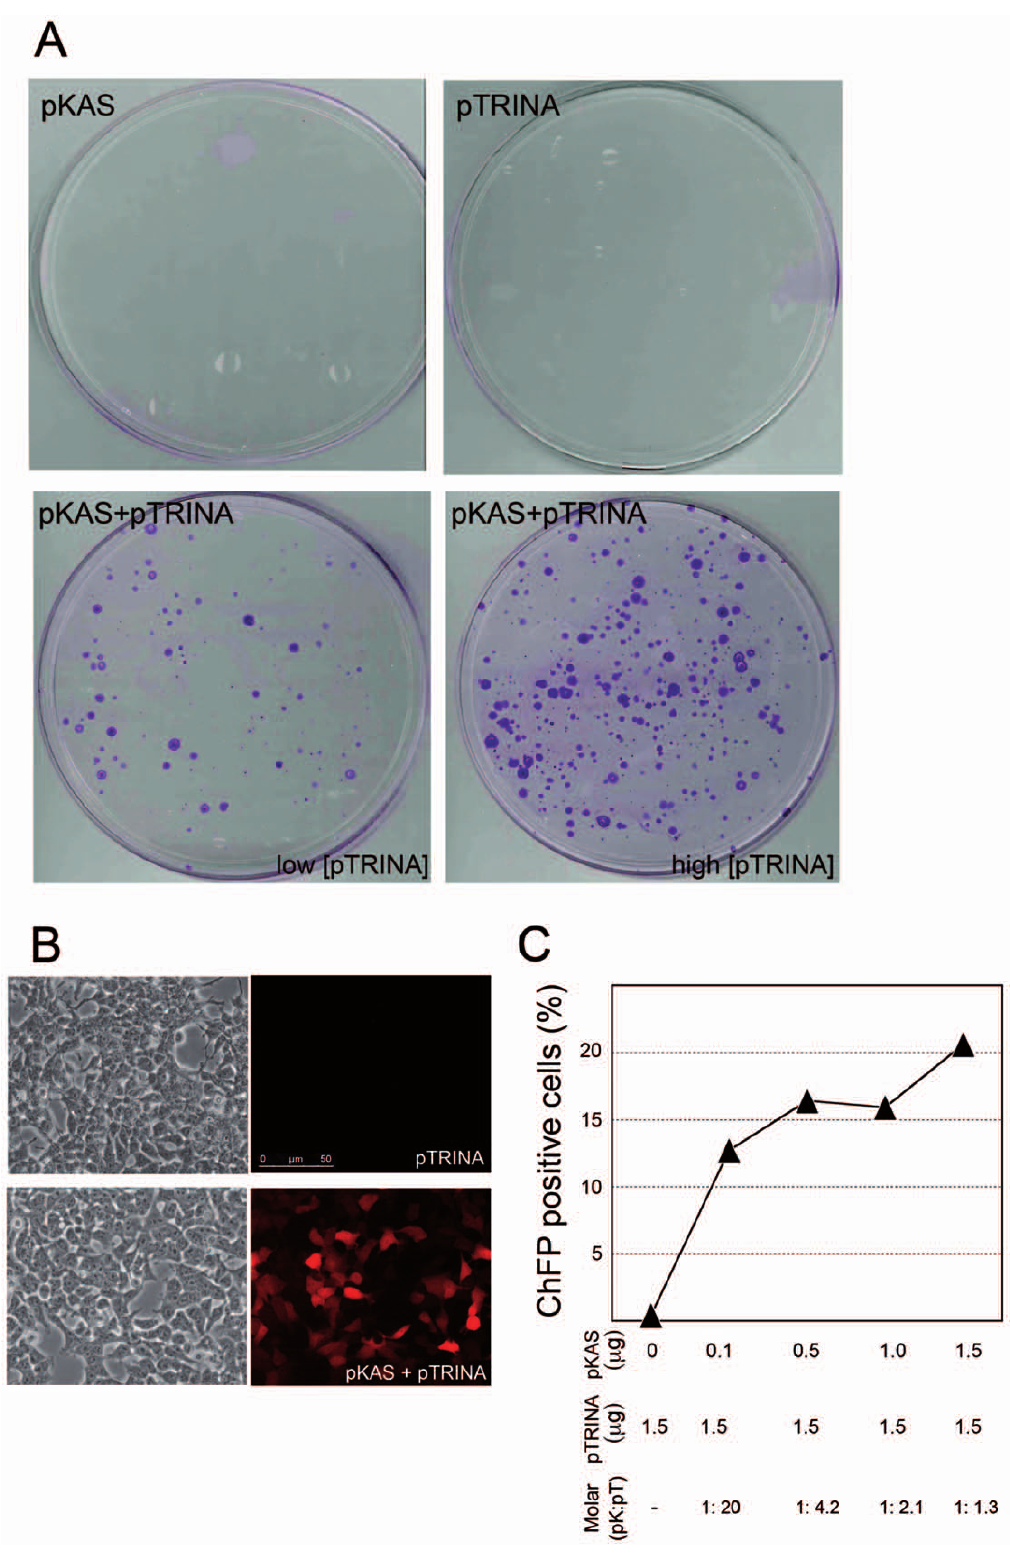
Figure 2. Plasmid-mediated RMCE by transient transfection. (A) Hygromycin-resistant colonies obtained upon transfection of HEK293A cells with the indicated plasmids containing the genetic landing pad (pKAS) or the transfer plasmid (pTRINA) expressing cre-recombinase at two different relative amounts (low and high [pTRINA]). Colonies were stained after ten days under conditions of selection. (B) Microphotographs under brightfields (left) and fluorescent light (right) of the transfected cultures with the indicated plasmids. (C) Number of cells expressing cherry fluorescent protein (ChFP + ) upon RMCE on HEK293A cells measured by FACS analysis. Variable amounts of pKAS were used with a constant amount of pTRINA as is indicated. Transfections were made in duplicate, and the results shown in both A and B are from one representative experiment out of three.